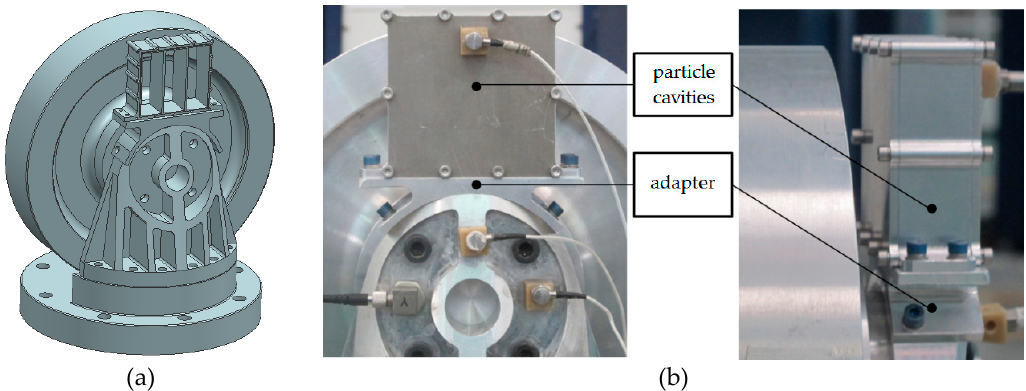
Figure 3. Connection scheme of particle cavities with the primary structure. ( a ) bracket structure; ( b ) test model.